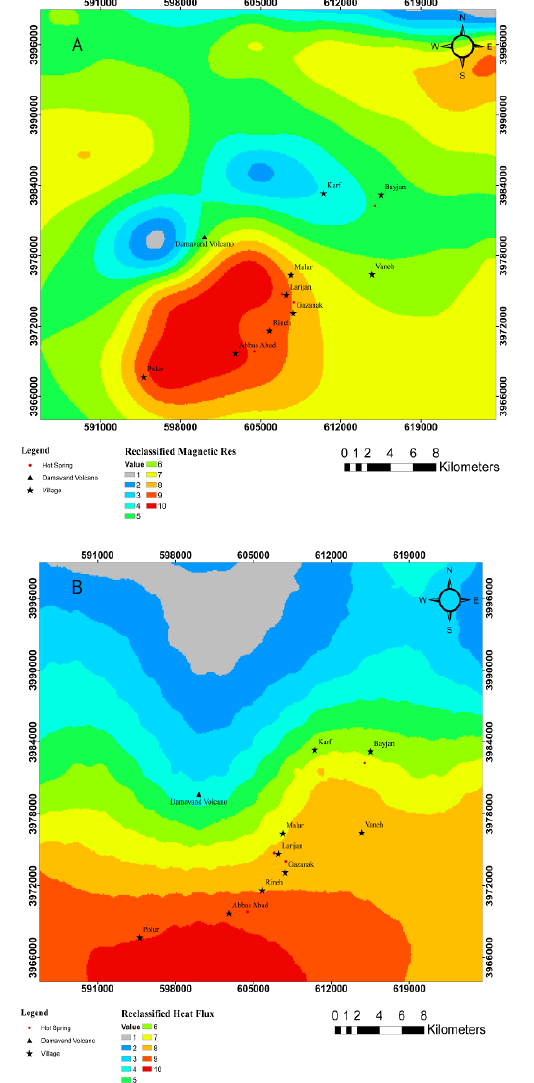
Figure 3. Geophysical Factor Classified map A) RTP map. B)